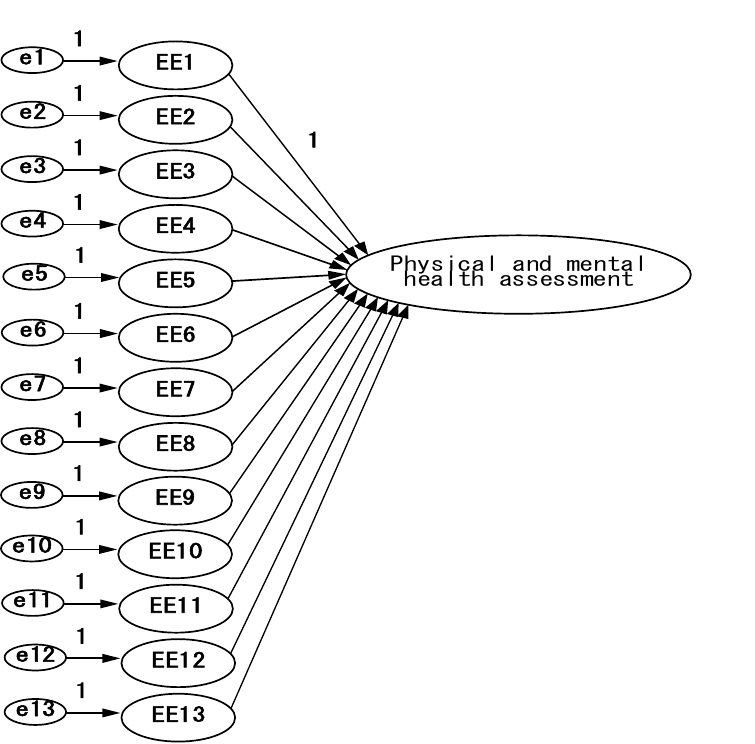
Figure 4. Epidemic prevention attitude model—confirmatory factor analysis framework.